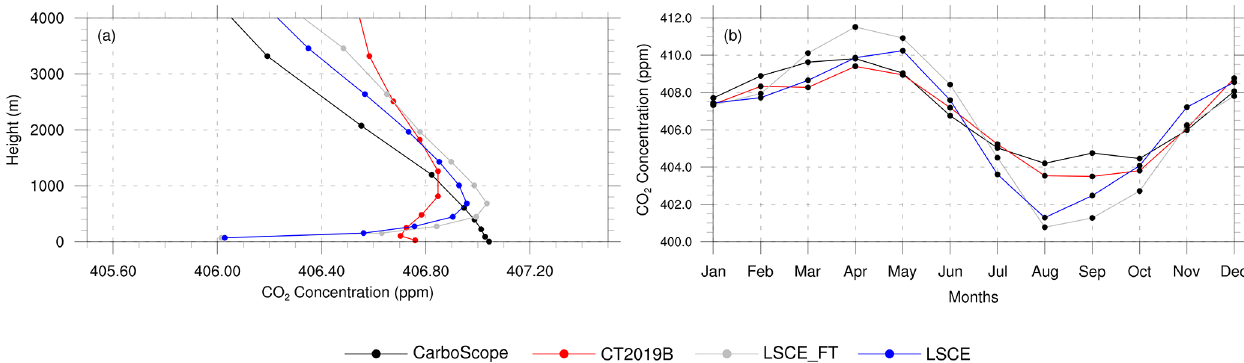
Figure 2. Comparison of global models over the model domain during daytime (11:30 to 16:30LT) in 2017. (a) Annually averaged vertical profiles of CO 2 concentration in the lower troposphere. (b) Time series of monthly averaged CO 2 concentration at surface ( ∼ 100m above surface).